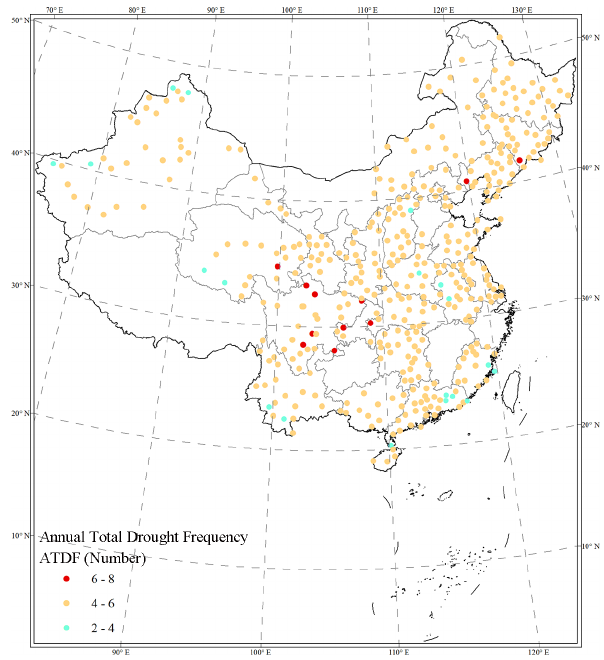
Figure 5. The spatial distribution of ATDF across mainland